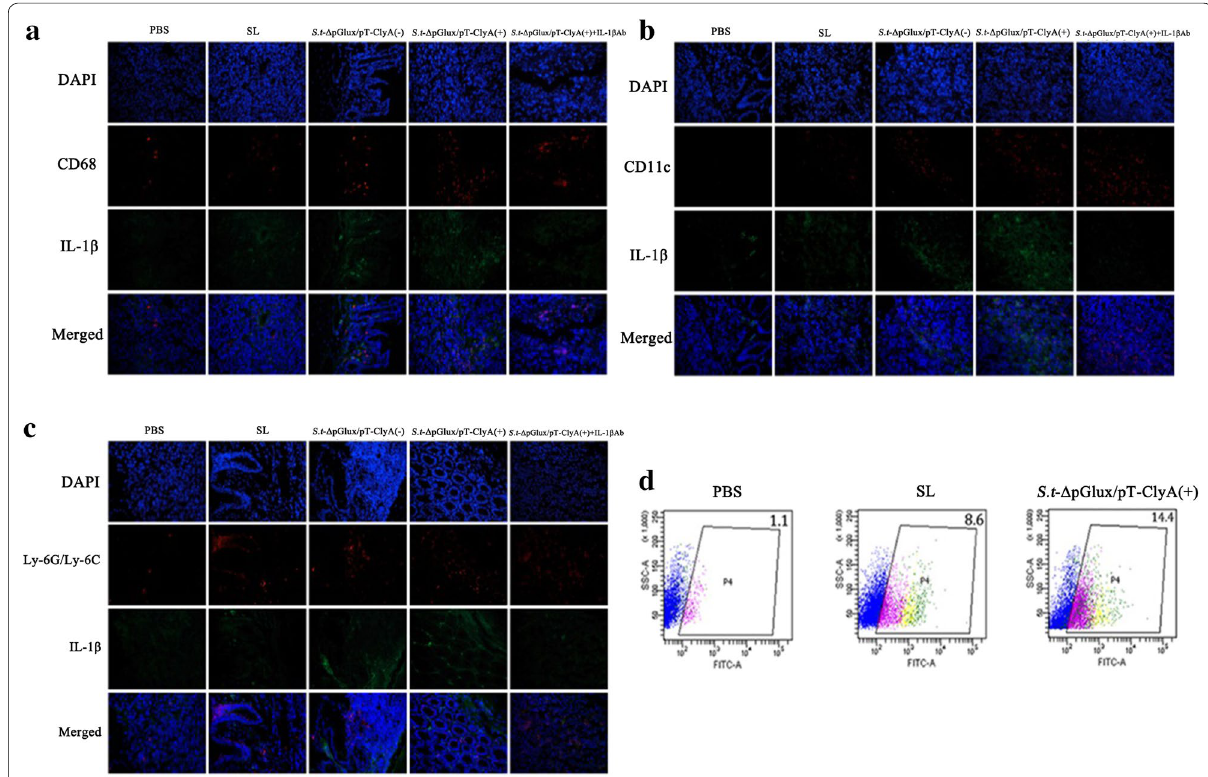
Fig. 6 Analysis of immune cell accumulation in tumor tissues and levels of IL-1β. a – c Tumor tissue was excised and fixed in 3 dpi, cryo-sectioned, and immunostained for IL-1β plus CD68 (macrophages), Ly-6G/ls), or CD11c (dendritic cells). Representative images from three independent experiments are shown. d Flow cytometry analysis was used to examine levels of IL-1β in each group in the tumor-draining